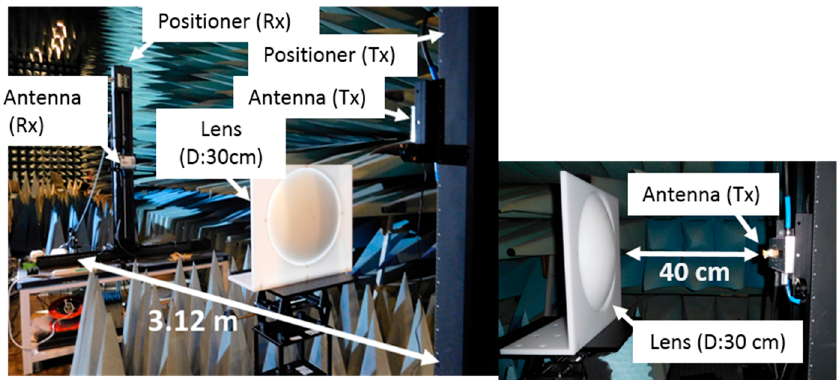
Figure 4. Experimental environment (OAM multiplexing using dielectric lens). Table 1. Experimental parameters (Dielectric lens).